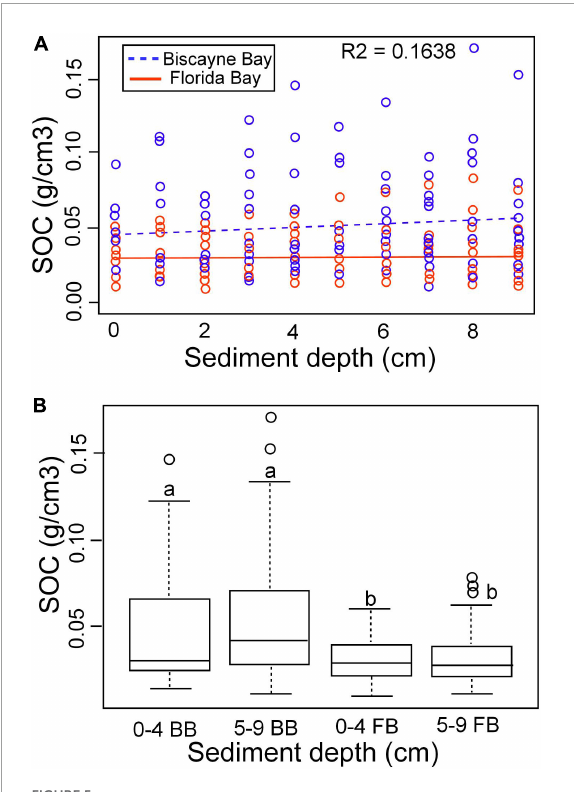
FIGURE5 (A) Relationship between SOC density and sediment depth by location. (B) Relationship among SOC, depth interval and location. BB, Biscayne Bay; FB, Florida Bay.